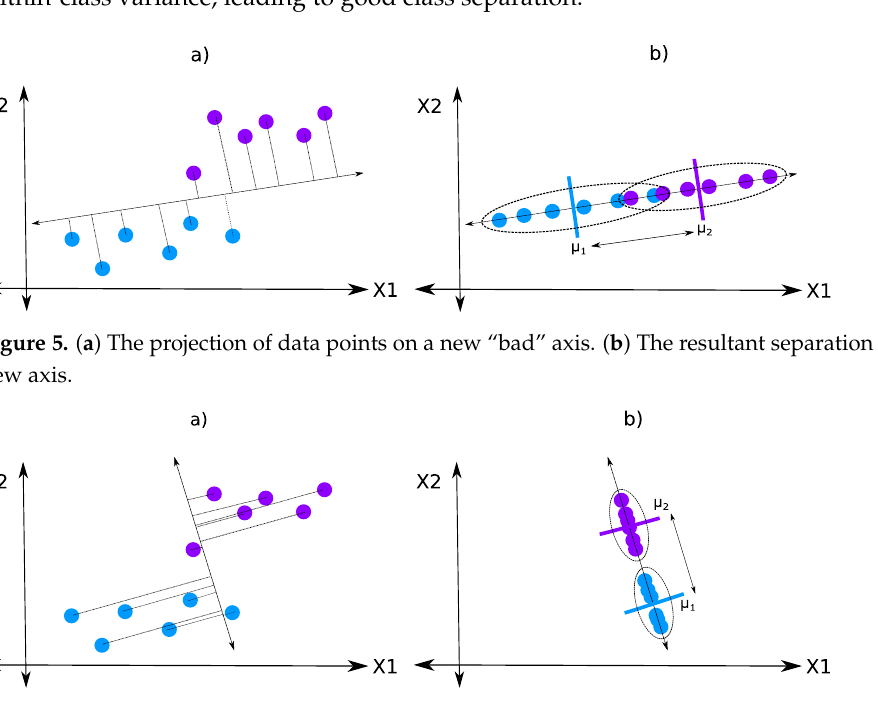
Figure 6. ( a ) The projection of data points on a new “good” axis. ( b ) The resultant separation with the new